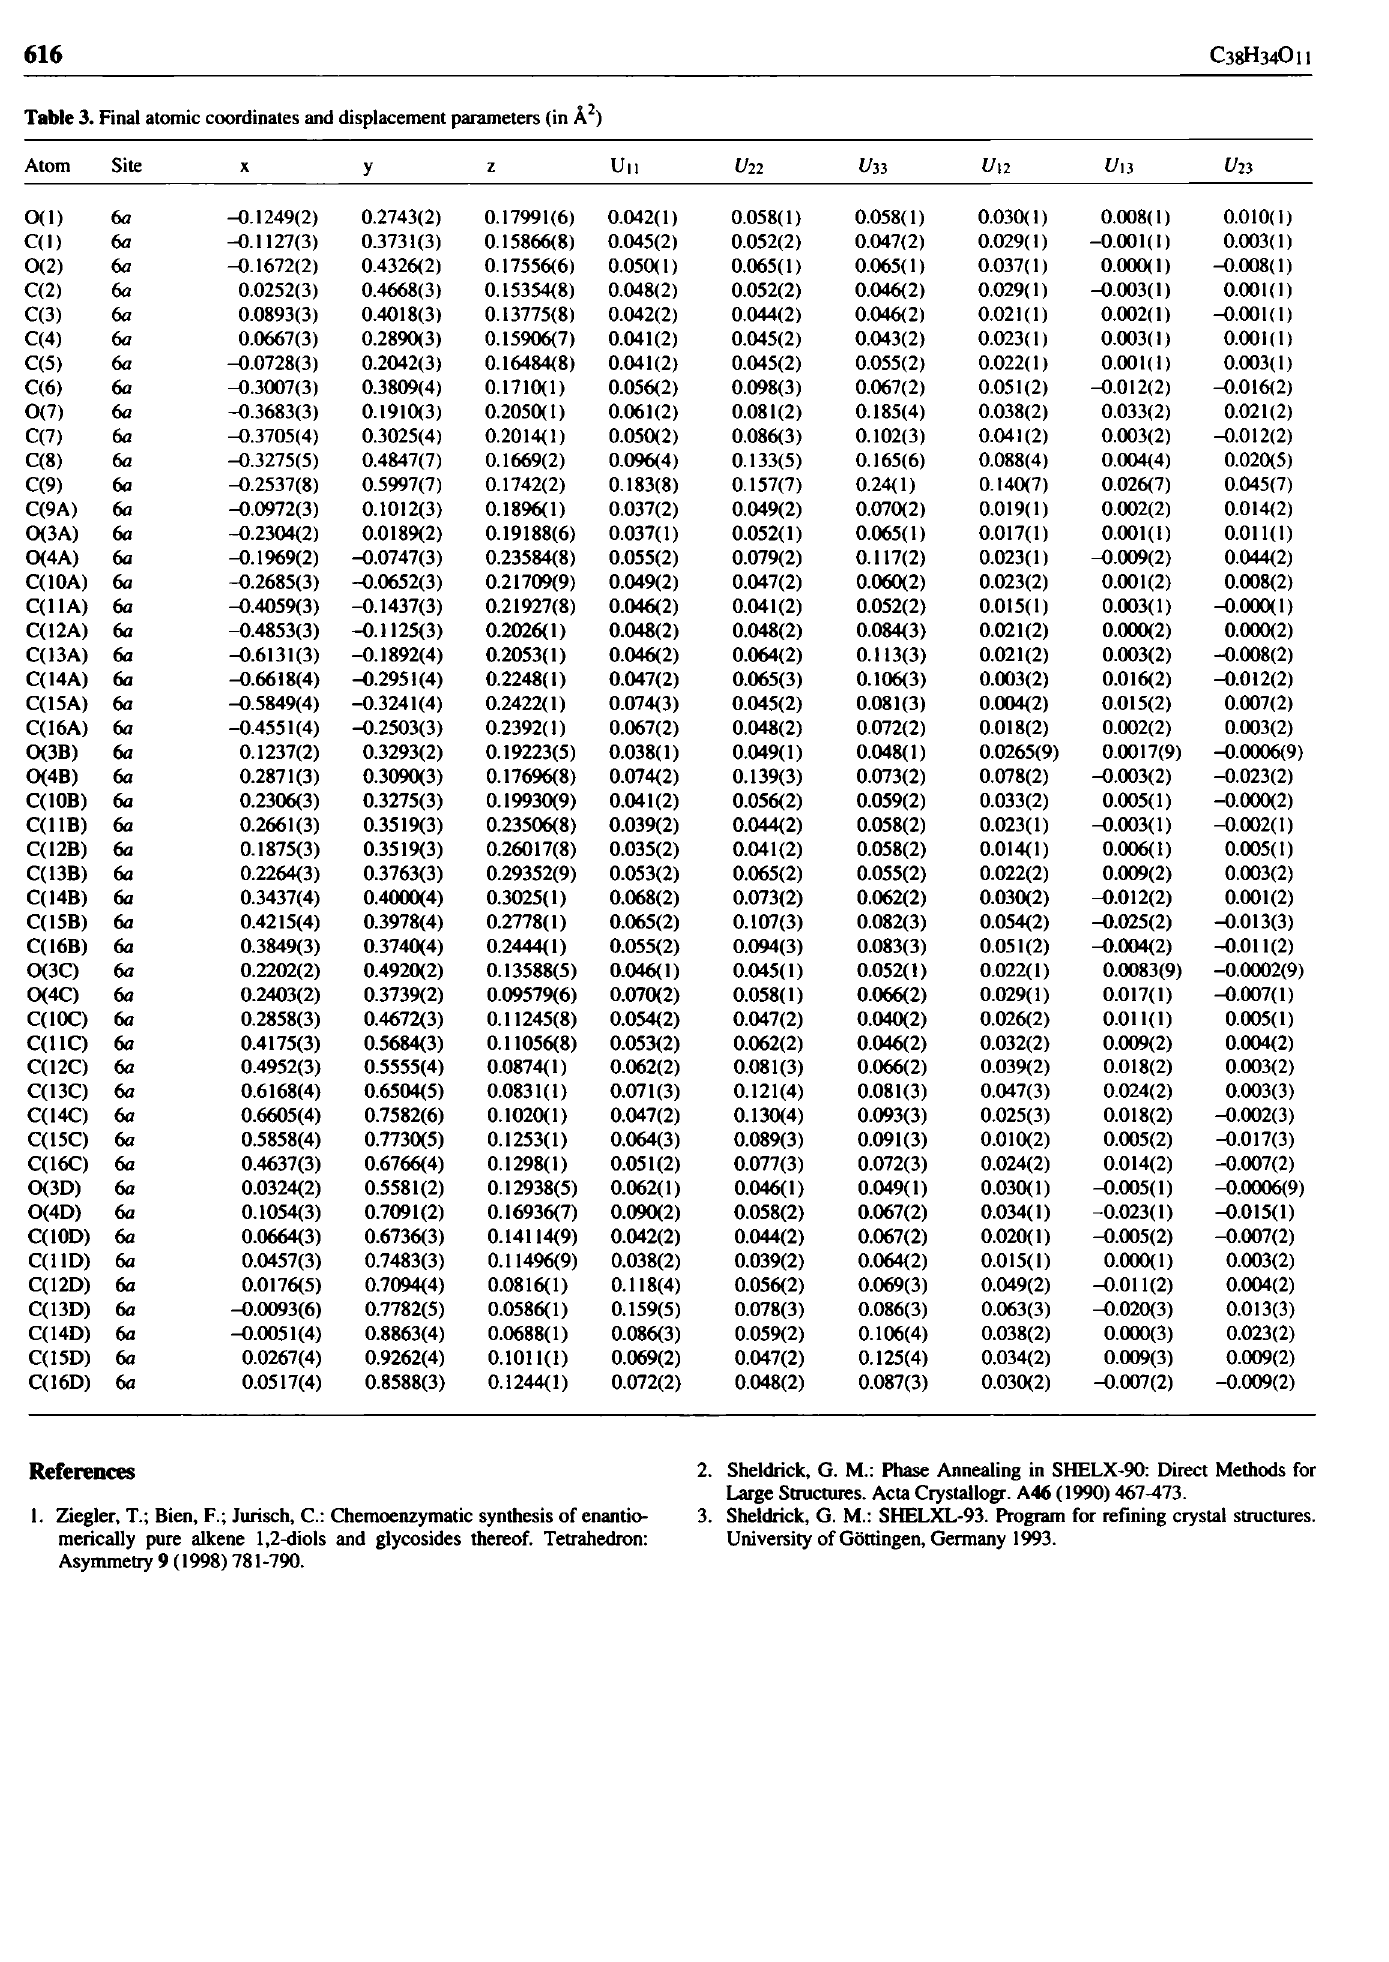
Table 3. Final atomic coordinates and displacement parameters (in